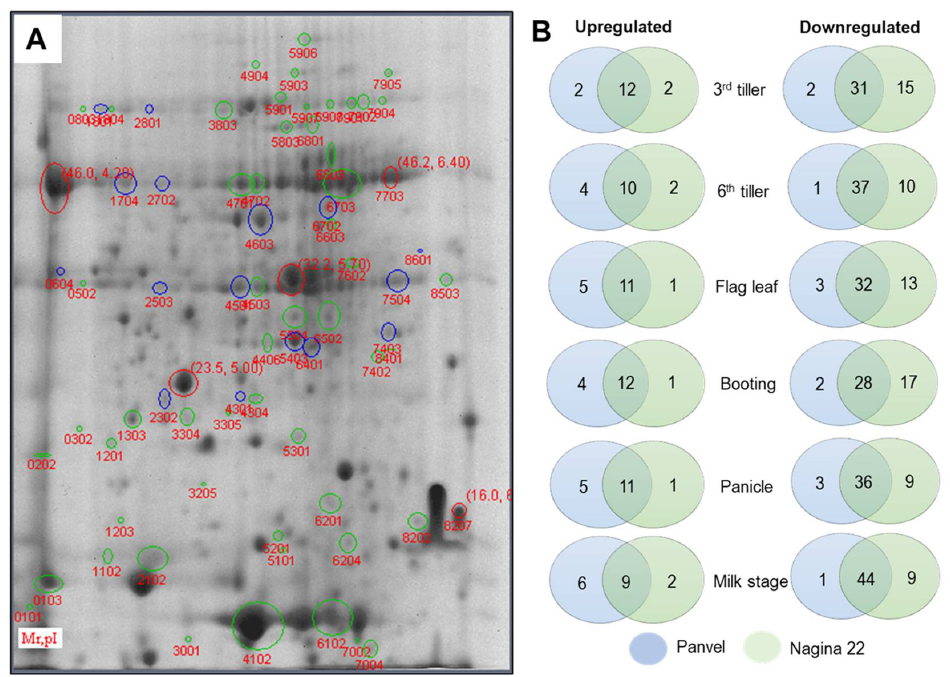
Figure 5. Differentially expressed proteins (DEP) and their variation between Panvel and Nagina 22 at different growth stages under low–N supply. Representation of DEPs on gel map, blue and green circled spots are upregulated and downregulated proteins, respectively; and red circled spots are references for experimental molecular weight and isoelectric point ( A ). Venn diagrams represent the differences of upregulated and downregulated proteins between rice cultivars and growth stages under low-N supply ( B ).